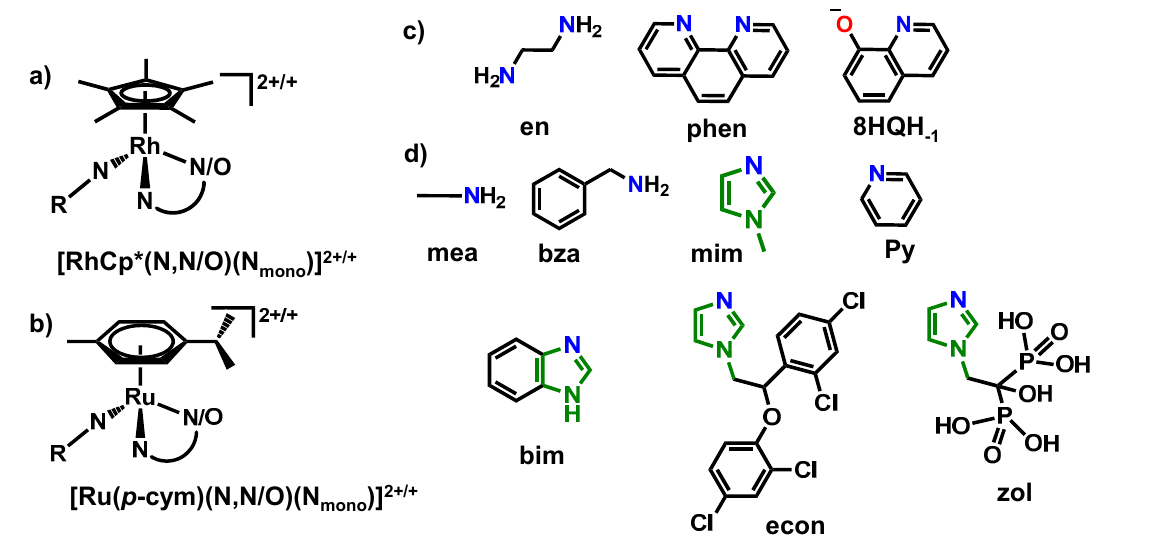
Chart 2. General structure of the mixed‑ligand ( a ) RhCp* and ( b ) Ru ( p ‑cym) complexes. ( c ) The used bidentate ligands with (N,N) and (N,O) donor atoms and ( d ) monodentate N‑donor ligands. (The counter ions are Cl − , CF 3 SO 3 − , or BPh 4 − , as indicated in the experimental section for each com ‐ plex.).